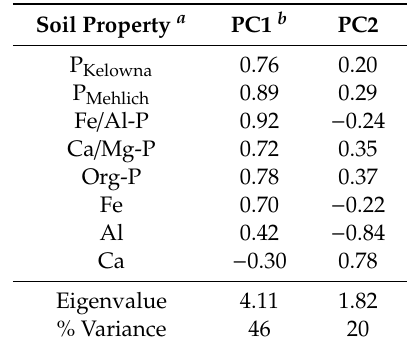
Figure 3. Principal component analysis of soil parameters related to P status in soils of six cropland and forestland in shelterbelt systems.